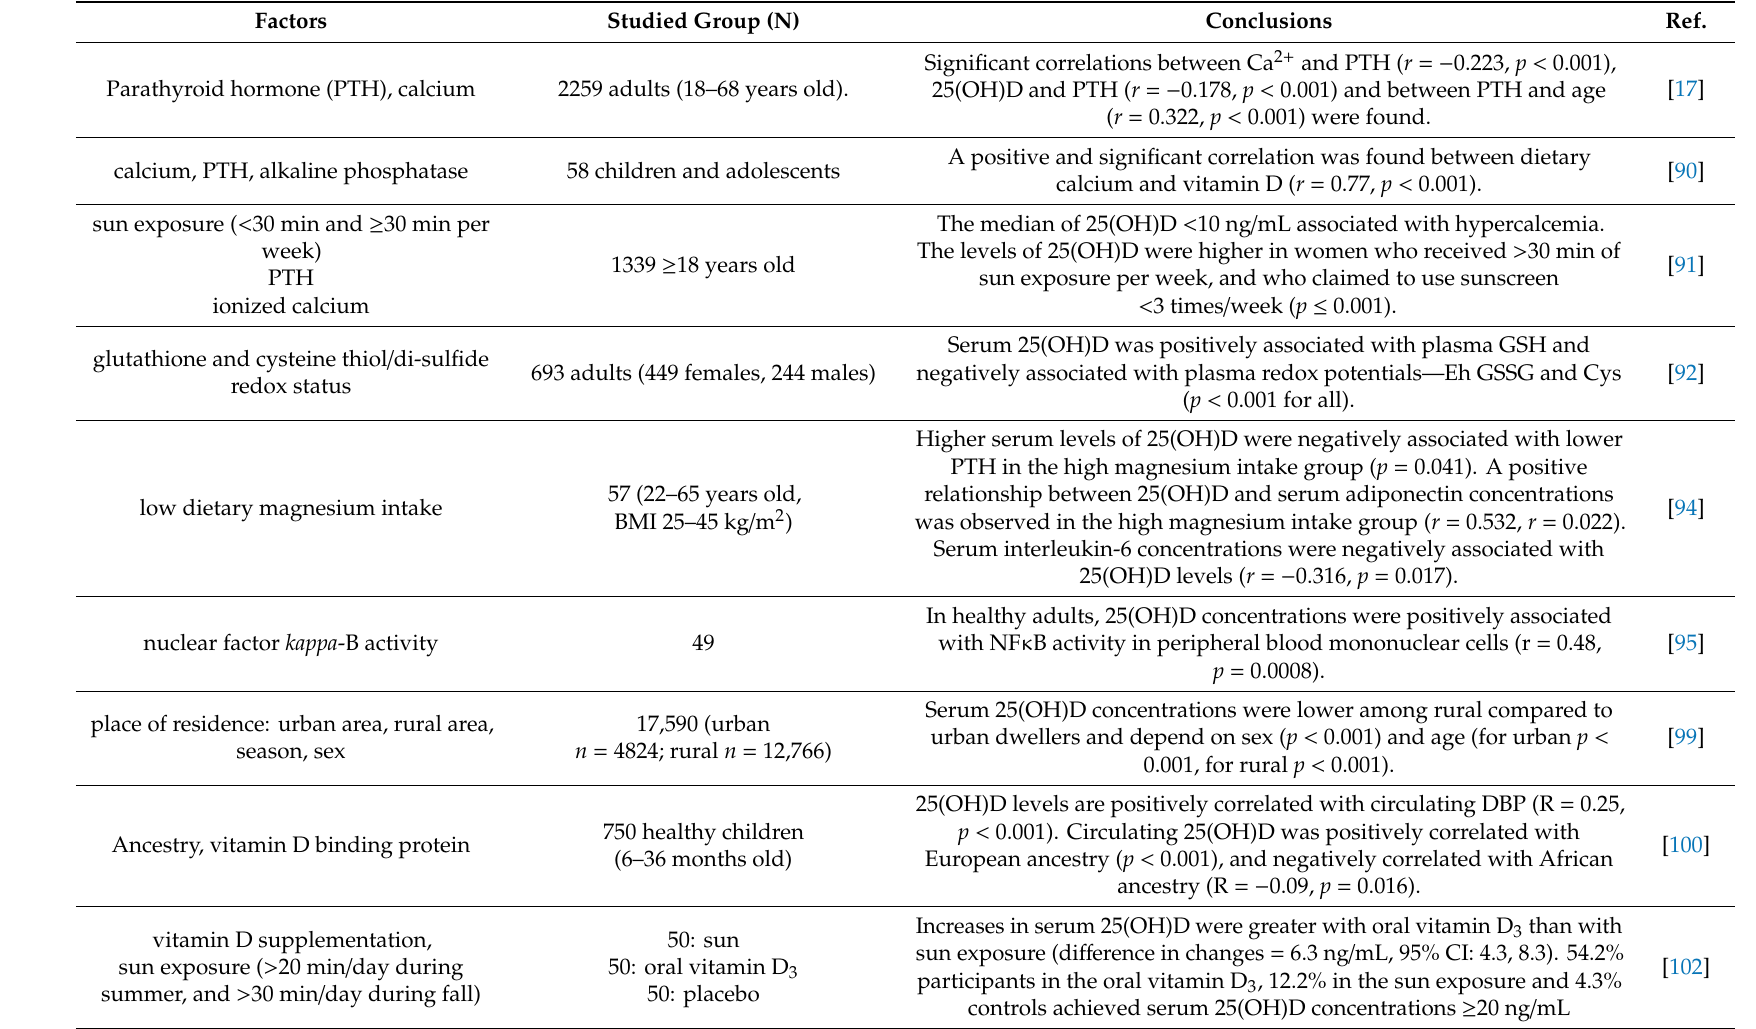
Table 3. Factors influencing vitamin D status in human